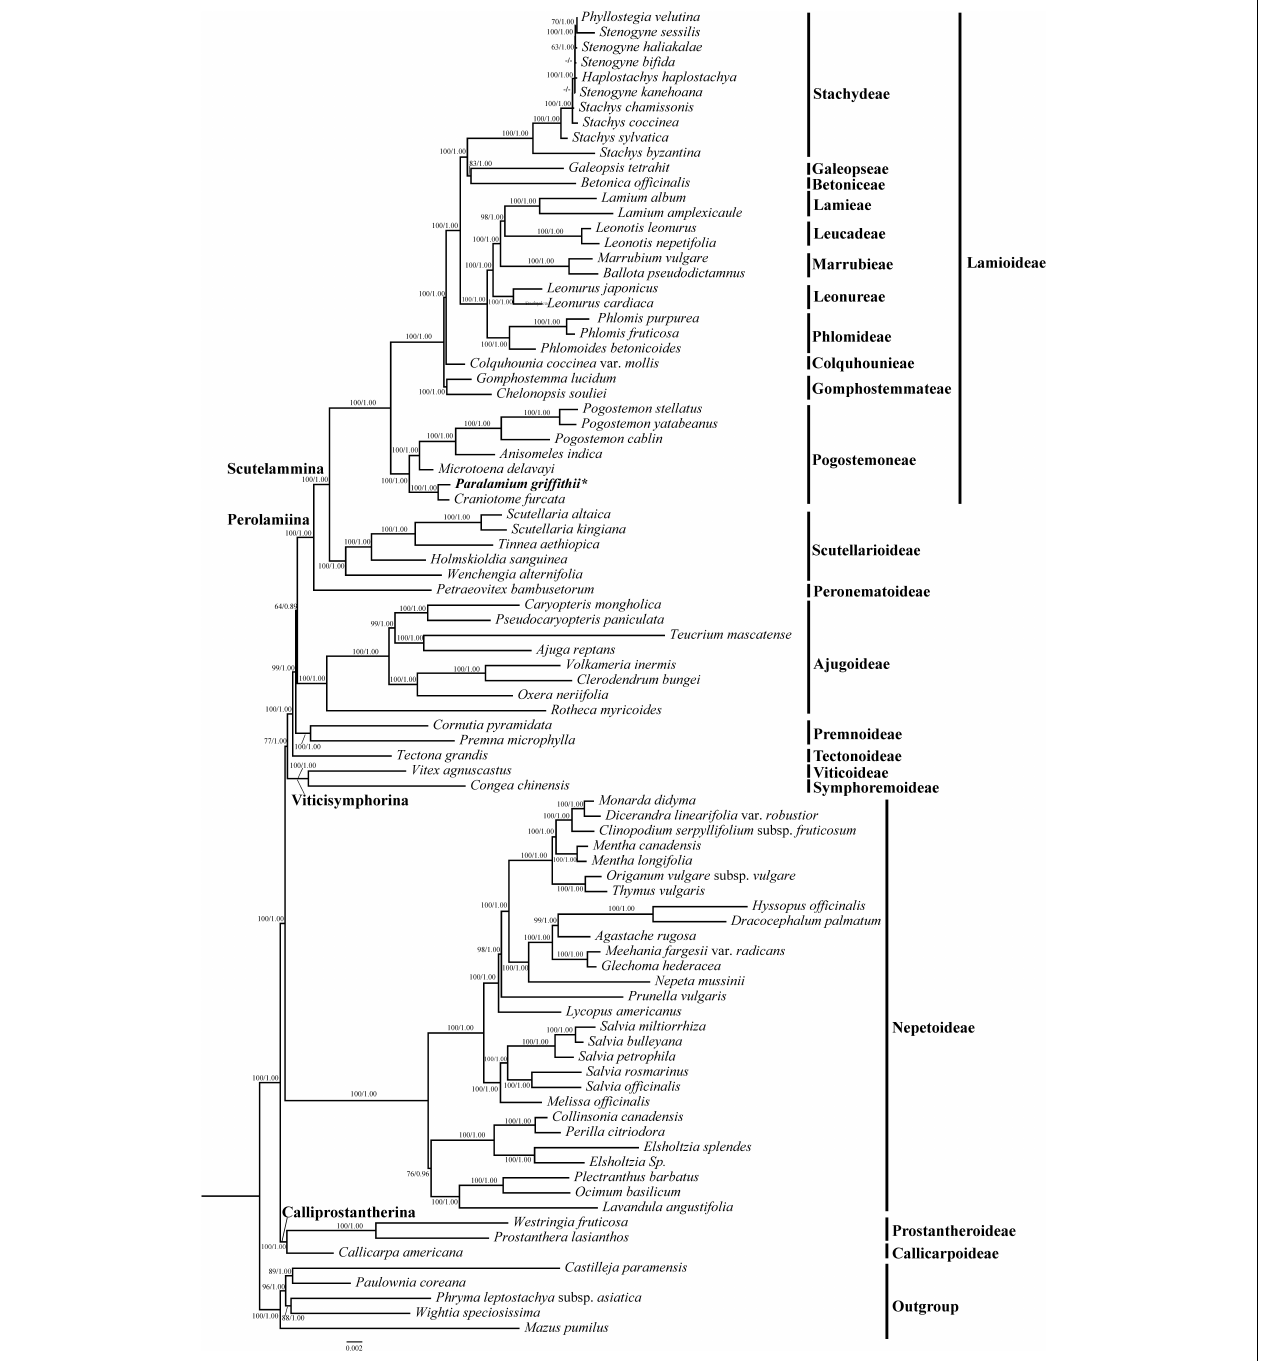
FIGURE 2 | Phylogeny of Lamiaceae inferenced by maximum likelihood (ML) based on 79 coding regions (dataset CP79), with ambiguously aligned sites excluded from analysis. Bootstrap values ≥ 50% in ML and posterior probability values ≥ 0.90 in BI analyses displayed on the branch follow the order ML BS /BI PP (“-” indicates a support value BS < 50% or PP values < 0.9). Subfamilial classification of Lamiaceae is based on Li et al. (2016) and Li and Olmstead (2017).